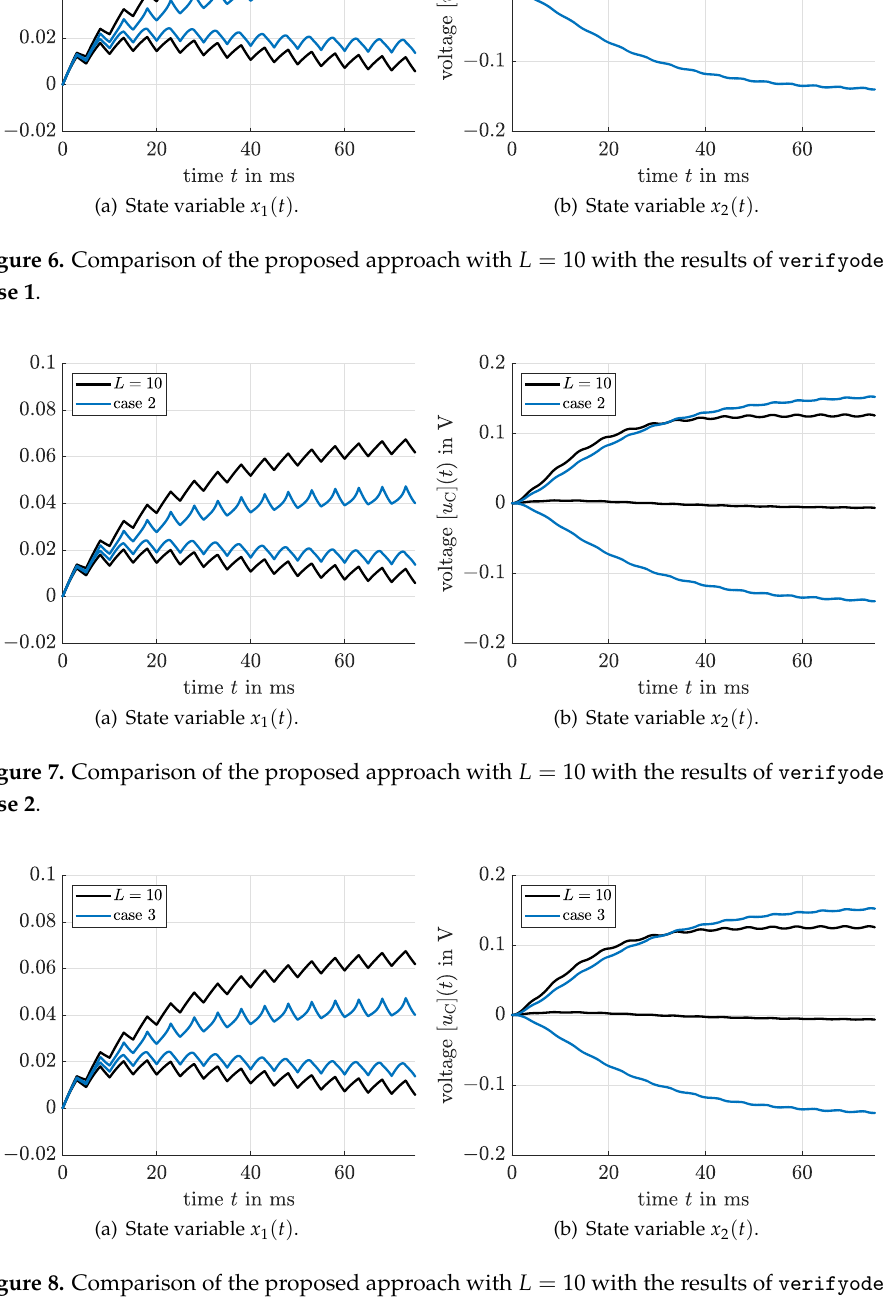
Figure 8. Comparison of the proposed approach with L = 10 with the results of verifyode for the case 3